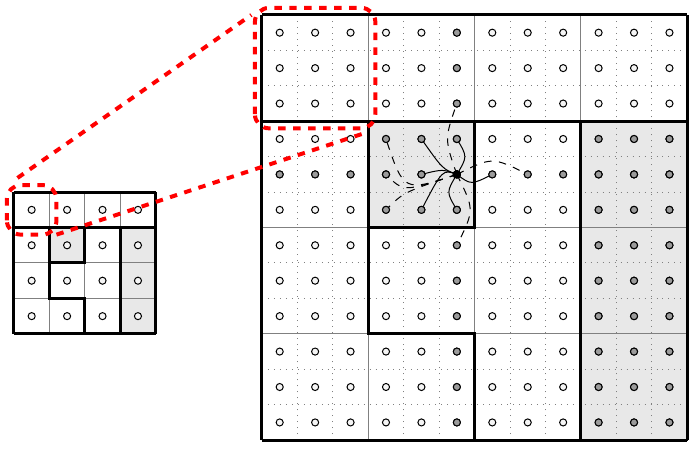
Figure 2: 3 -fold blow up of the free-form 2 -Sudoku puzzle from Figure 1